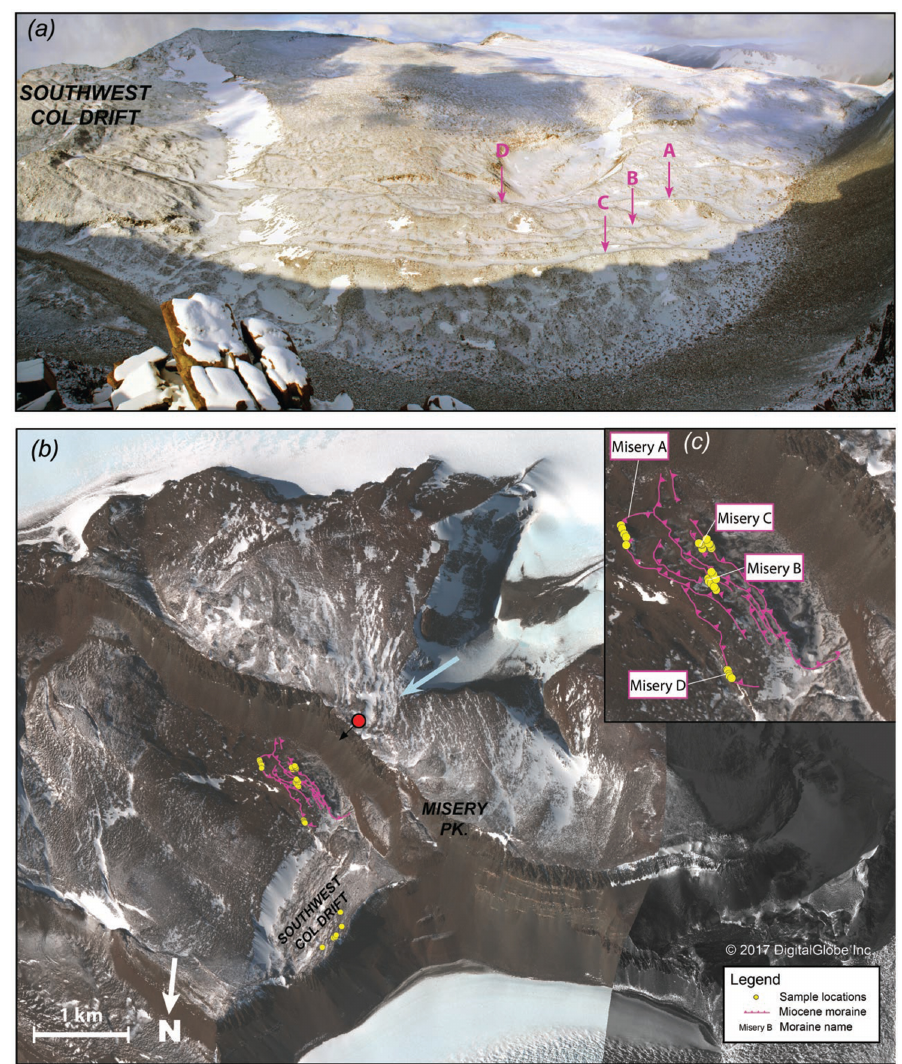
Figure 8. Map of Misery Platform. (a) Photo of the Misery moraines. Pink arrows point to the sampled Misery moraines and are labeled with the corresponding moraine letter. The location of the Southwest Col drift is also labeled. The photo was taken from the location of the red circle in (b) looking in the direction of the black arrow (vantage to the northeast). (b) Geomorphic map of the Southwest Col area. The Southwest Col drift mantles the bedrock outboard of the Misery moraines. The blue arrow denotes the direction of ice flow when the Misery moraines were deposited. (c) Closer view of the Misery moraine complex. The base map in (b) and (c) is derived from WorldView-2 satellite imagery (© 2017, DigitalGlobe,